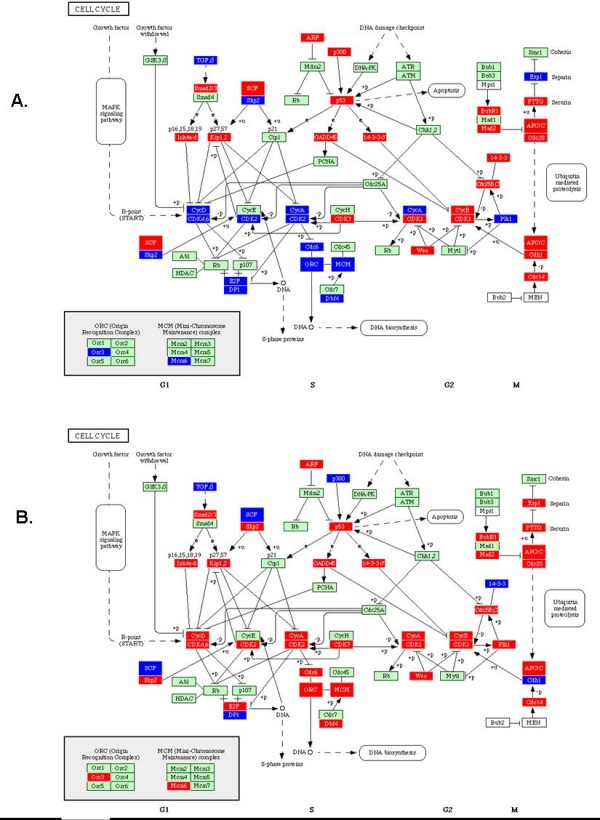
Impact of a mixed microbial challenge on cell cycle control in HIGK. Transcriptional regulation of the KEGG cell cycle pathway modulated by infection with P. gingivalis alone (A) or a mixture of P. gingivalis and S. gordonii (B). Genes represented by red boxes indicate up-regulated transcript levels compared to uninfected controls, where as those genes depicted in blue represent down-regulated transcript levels.